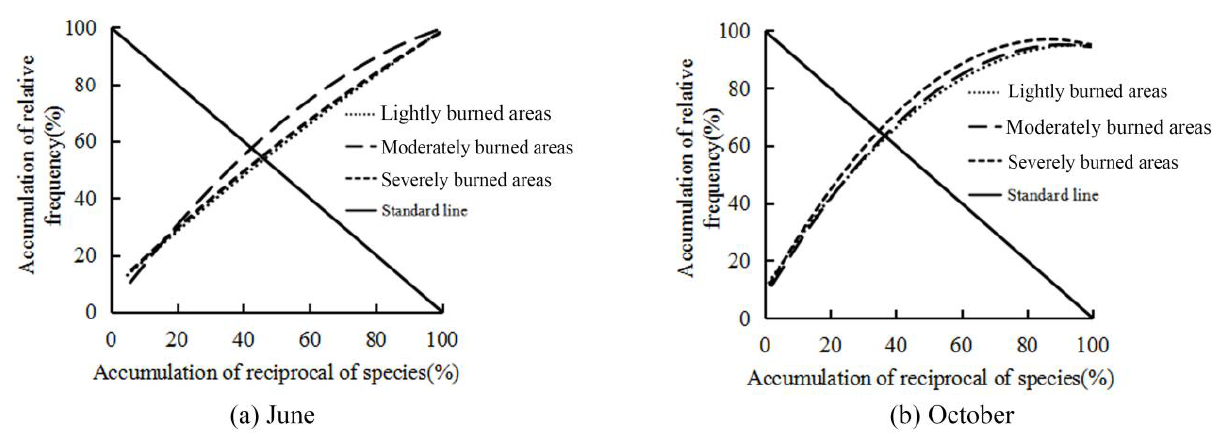
Figure 4. The stability of vegetation community with different fire severity. The stability fitting curve of the lightly burned area was y = − 0.0092x 2 + 1.7693x + 10.087 ( R 2 = 0.99), the coordinate of the intersection (37.2, 63.1), and the distance to the